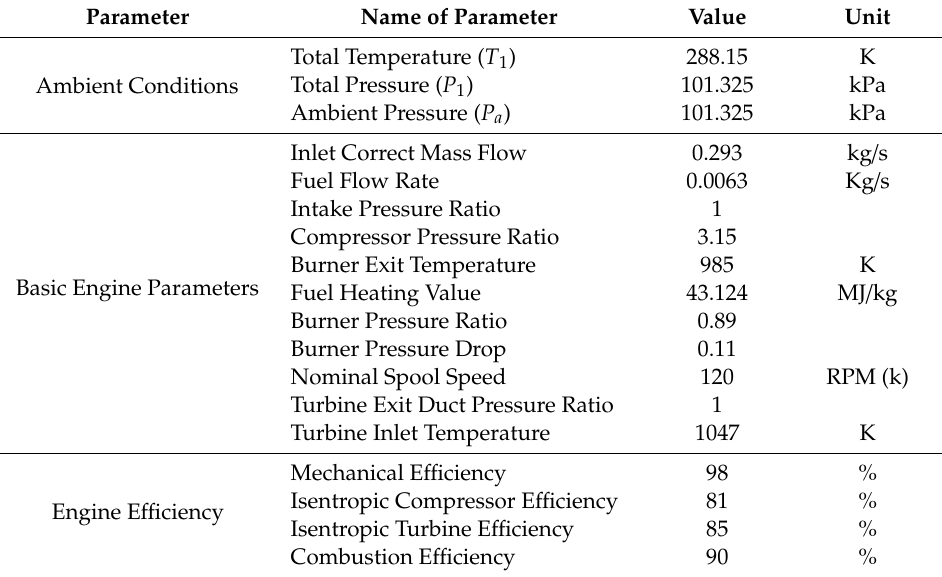
Figure 3. Baseline engine schematic with station numbering. Table 4. GasTurb13 Input Parameters for BMT 120 KS Engine.